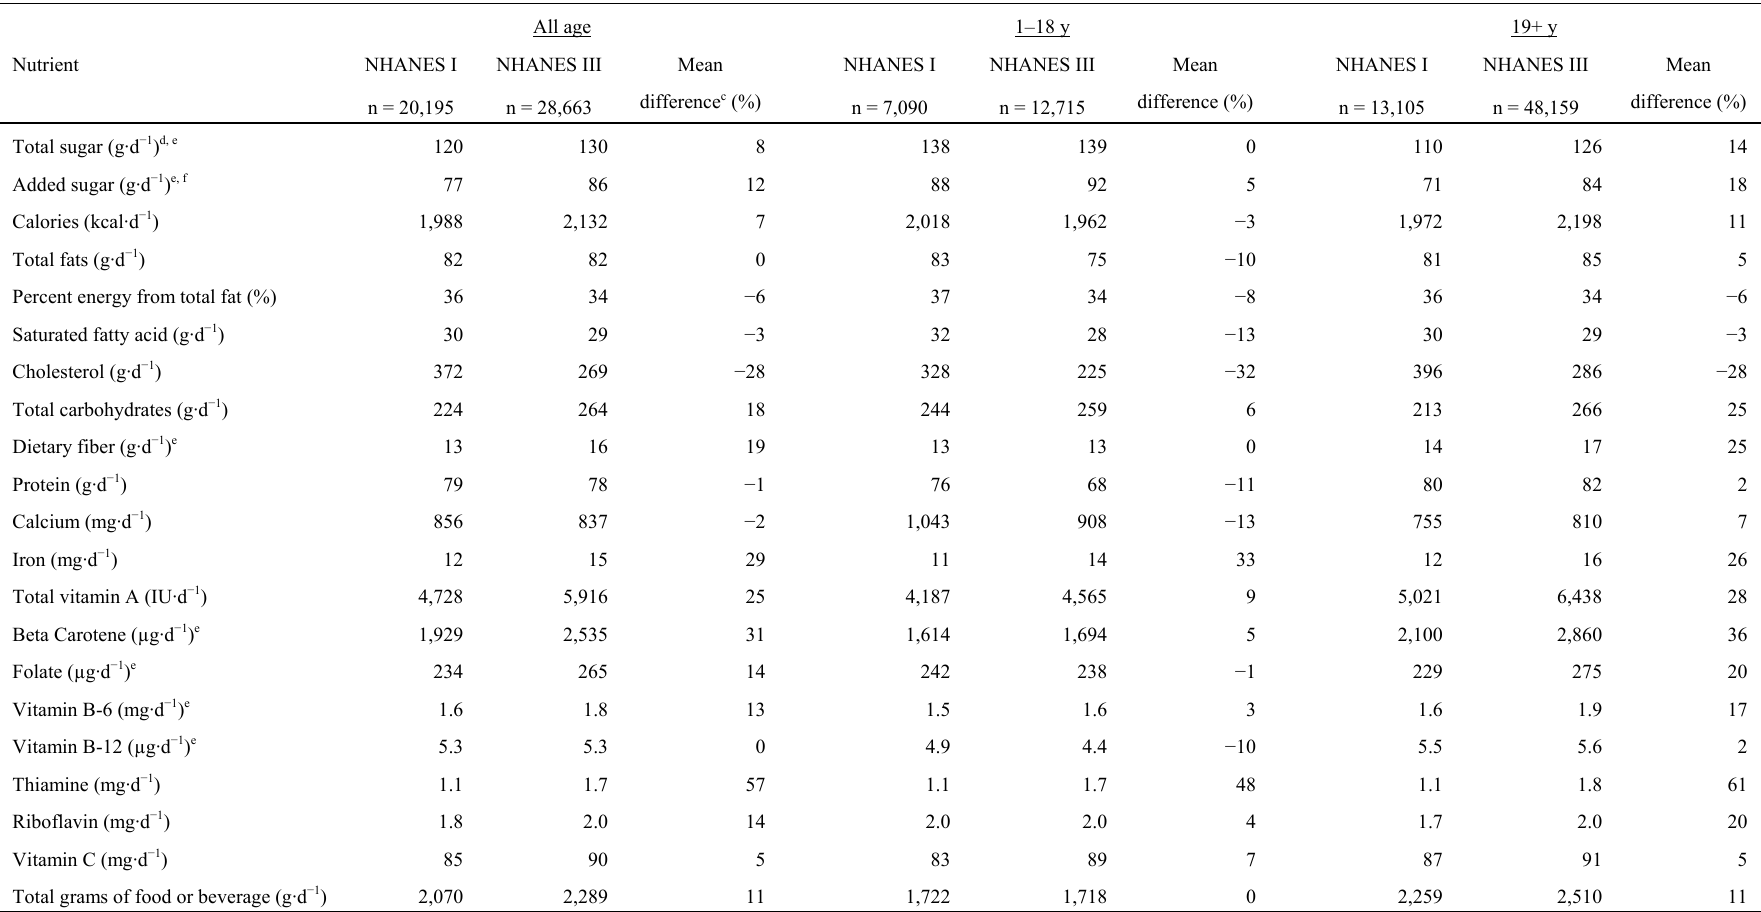
Table 3. Comparison of the mean daily nutrient intakes between the NHANES I (1971-75) and NHANES III (1988-94). a, b